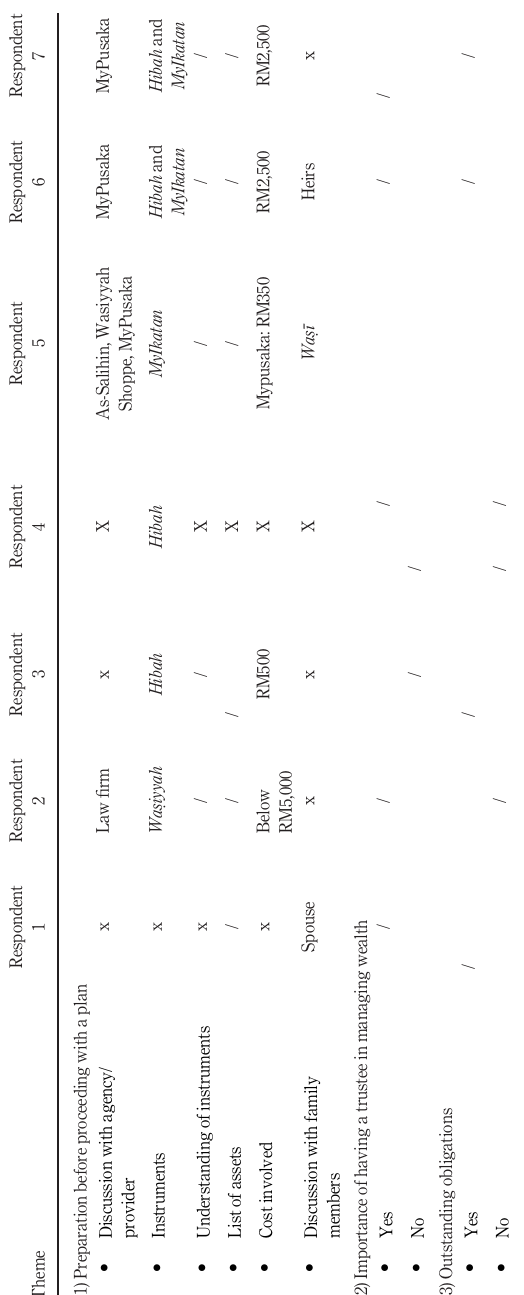
Table 3. Results of